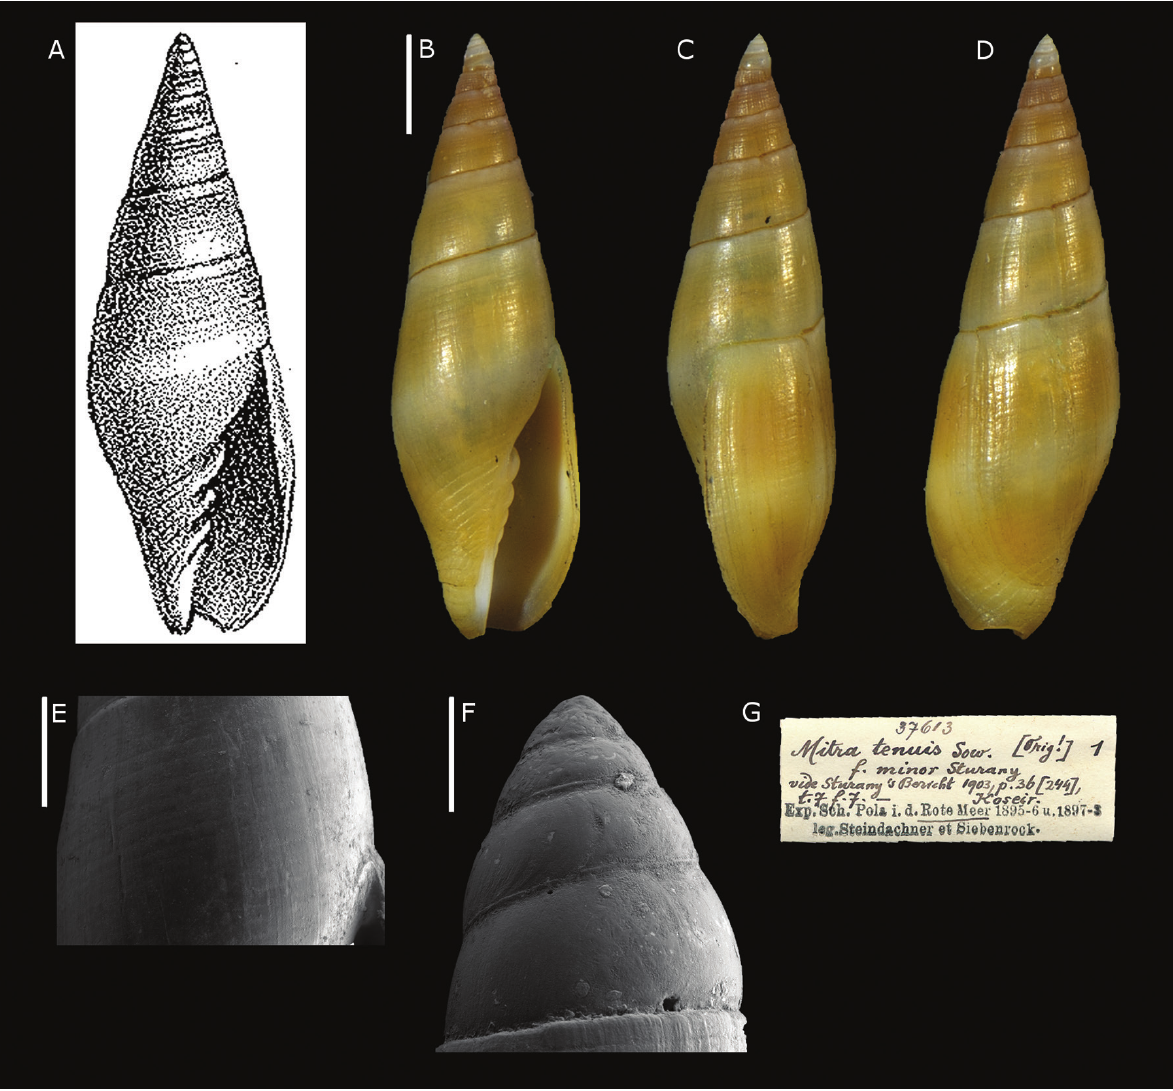
Figure 20. Mitra tenuis f. minor Sturany, 1903, Locality 21 (El Quseir, Egypt, Red Sea). A . Original figure by Sturany (1903). B–F . Figured syntype, NHMW 37613: front ( B ), right side ( C ), back ( D ), microsculpture ( E ), protoconch ( F ). G . Original label. Scale bars: B–D : 2 mm, E–F : 0.25 mm.